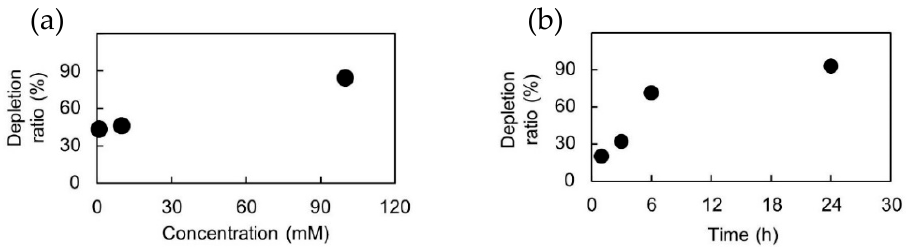
Figure 4. C-SPRA-MB using Ac-Lys beads and fluorescein-5-isothiocyanate (FITC). ( a ) Ac-Lys beads were tested with 1 mM, 10 mM, and 100 mM FITC for 24 h. ( b ) Ac-Lys beads were examined at chemical concentrations of 100 mM for 1, 3, 6, and 24 h.